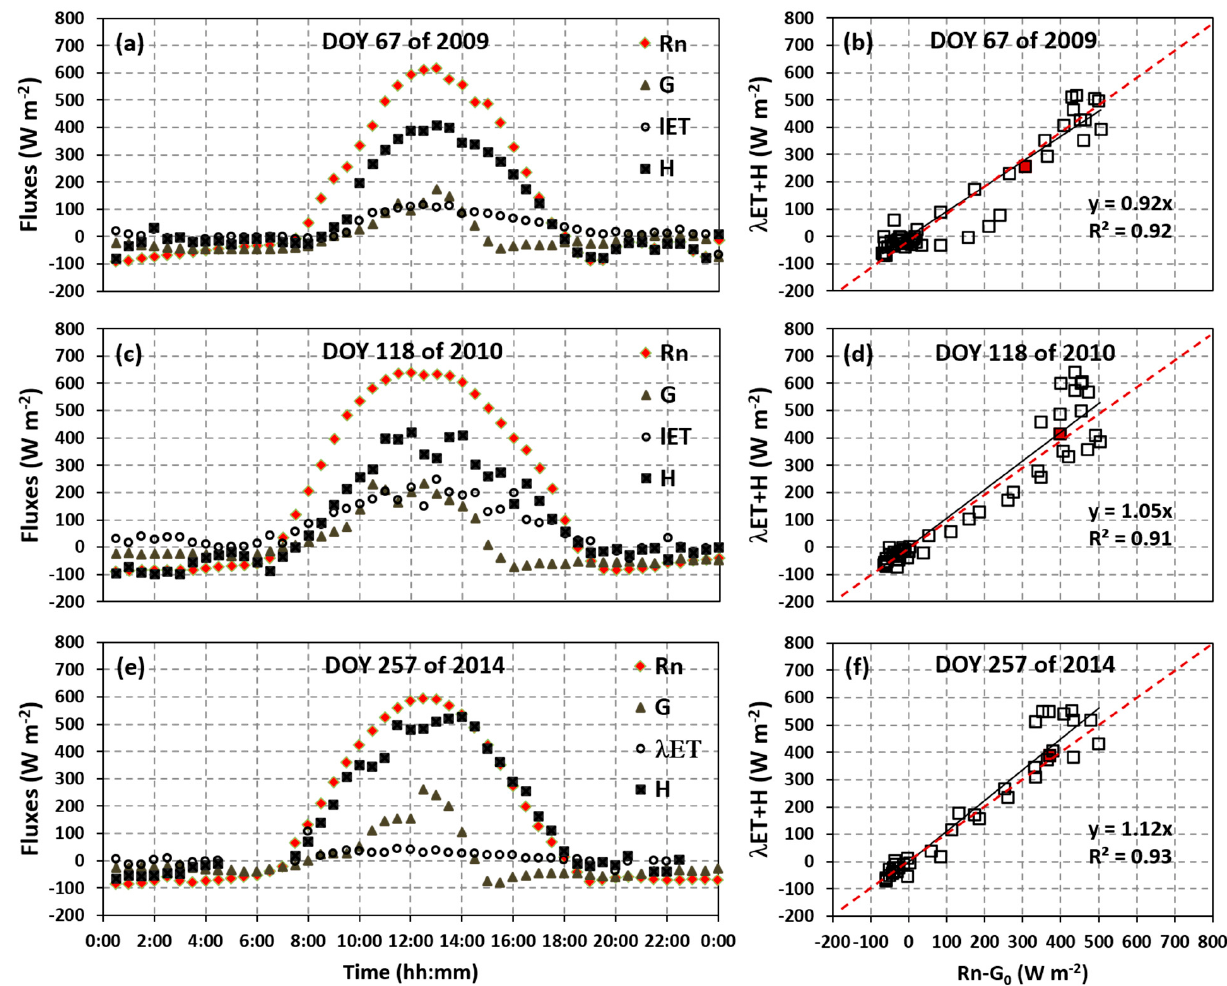
Figure 3. ( a , c , e ) Daily variation in 30 min surface energy balance components (Rn, G 0 , λ E and H). ( b , d , f ) The diurnal energy balance closure on DOY 672009, 1182010 and 2572014, respectively. The red-filled squares represent the energy budget closure near the image acquisition time (at 10:00). The red dashed line is the 1:1 line .